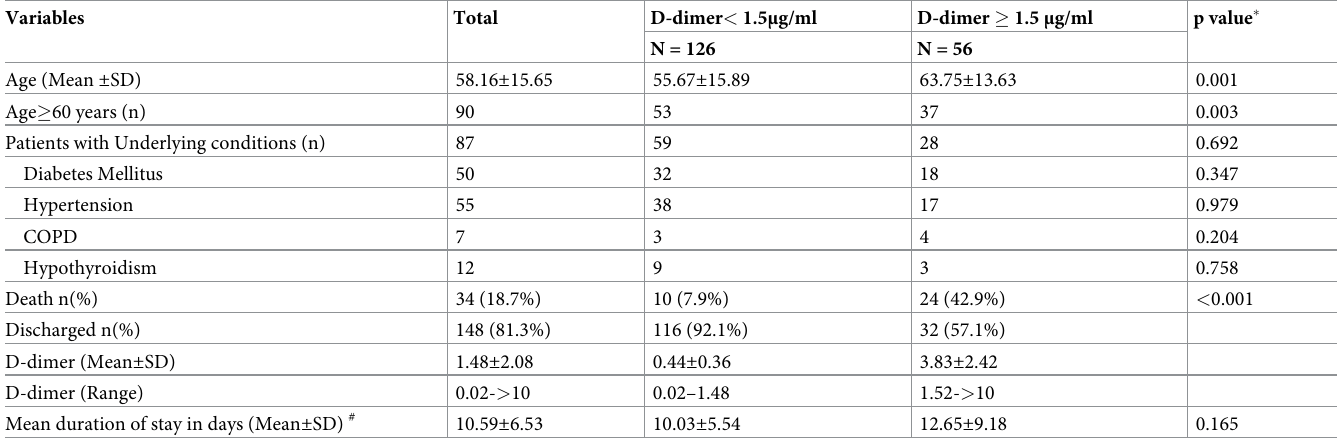
Table 1. Summary of 182 patients with COVID-19.